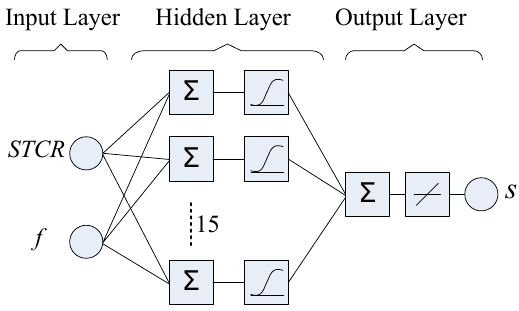
Figure 2. Schematic diagram of the feed-forward neural network.